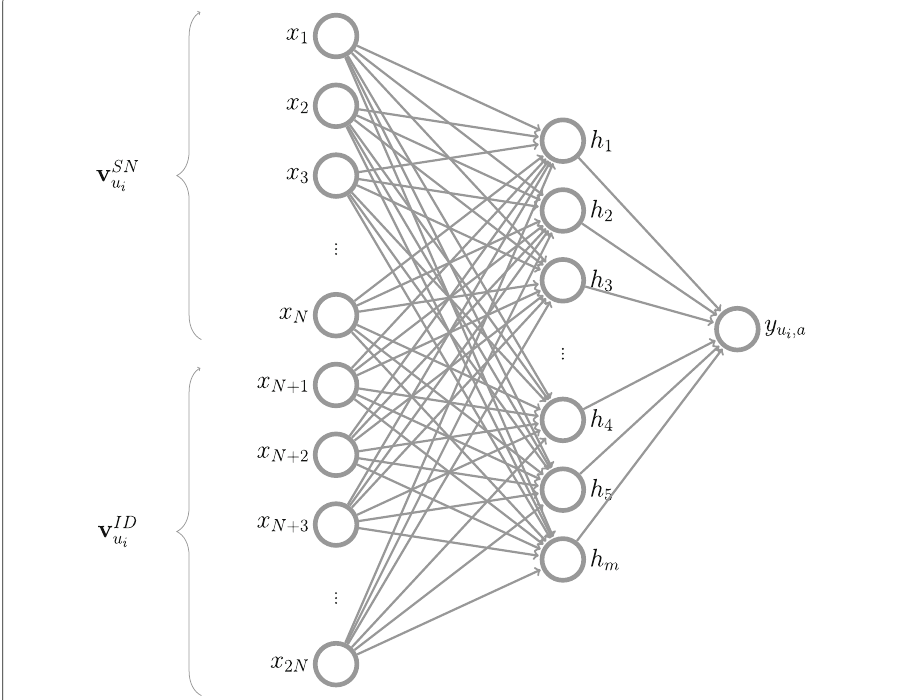
Fig. 3 Global-SIDL (G-SIDL). The input layer is composed of two concatenated vectors referred to as ) and socialnetworkvector ( v SN u target-userIDvector ( v ID u i target-user